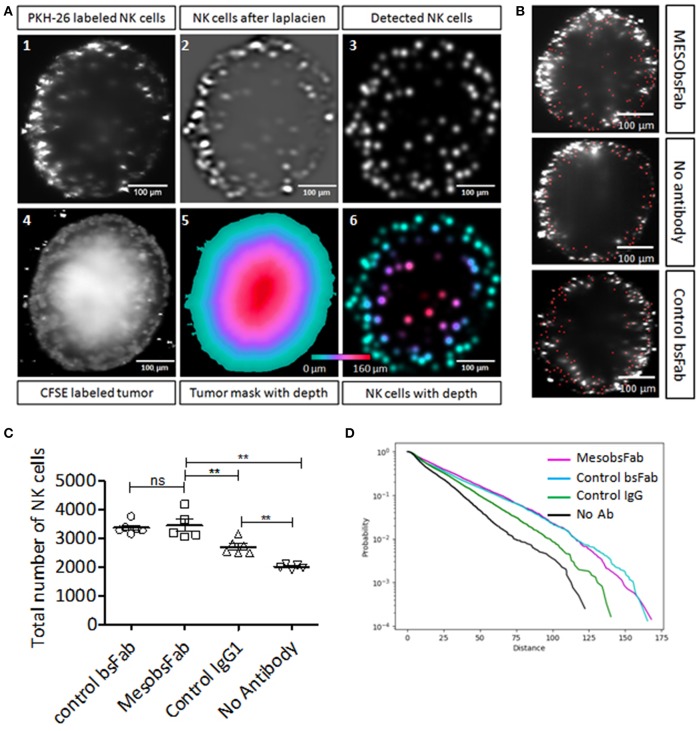
Impact of MesobsFab on NK cells infiltration into TNBC spheroids. (A) Cross-sections illustrating the 3D distance analysis method using ImageJ software. Multi-views images of spheroid were fused at 488 nm for visualizing CFSE-labeled tumor cells(A.4) and 561 nm for PKH-26-labeled NK cells (A.1). A Laplacian of Gaussian filter was applied to spatially filter the NK cells (A.2), then the NK cells were detected by measuring local maxima (A.3). A 3D mask (A.5) was created based on CFSE-labeled tumor cells (A.4) and used for measuring the distance of each NK cells from the spheroid surface (A.6) by computing the mask distance transform (A.5). (B) Representative images of infiltrated NK cells (red dots) into spheroid treated by MesobsFab, control bsFab, or without antibody. (C) Total number of NK cell detected into HCC1806 spheroid after 2 days of co-culture (E:T ratio 2.5:1) in the presence or absence of bsFab (50 nM). (D) Cumulative distribution curve representing the probability of NK cell infiltration based on the distance penetration. All spheroids size were homogeneous (CV < 6%) and had a radius size of 188.4 ± 10, 7 μm (n = 5–6/group). Data points represent the mean ± SEM and were analyzed by two-tailed Student's t-test. **P < 0.01 MesobsFab vs. no Ab.